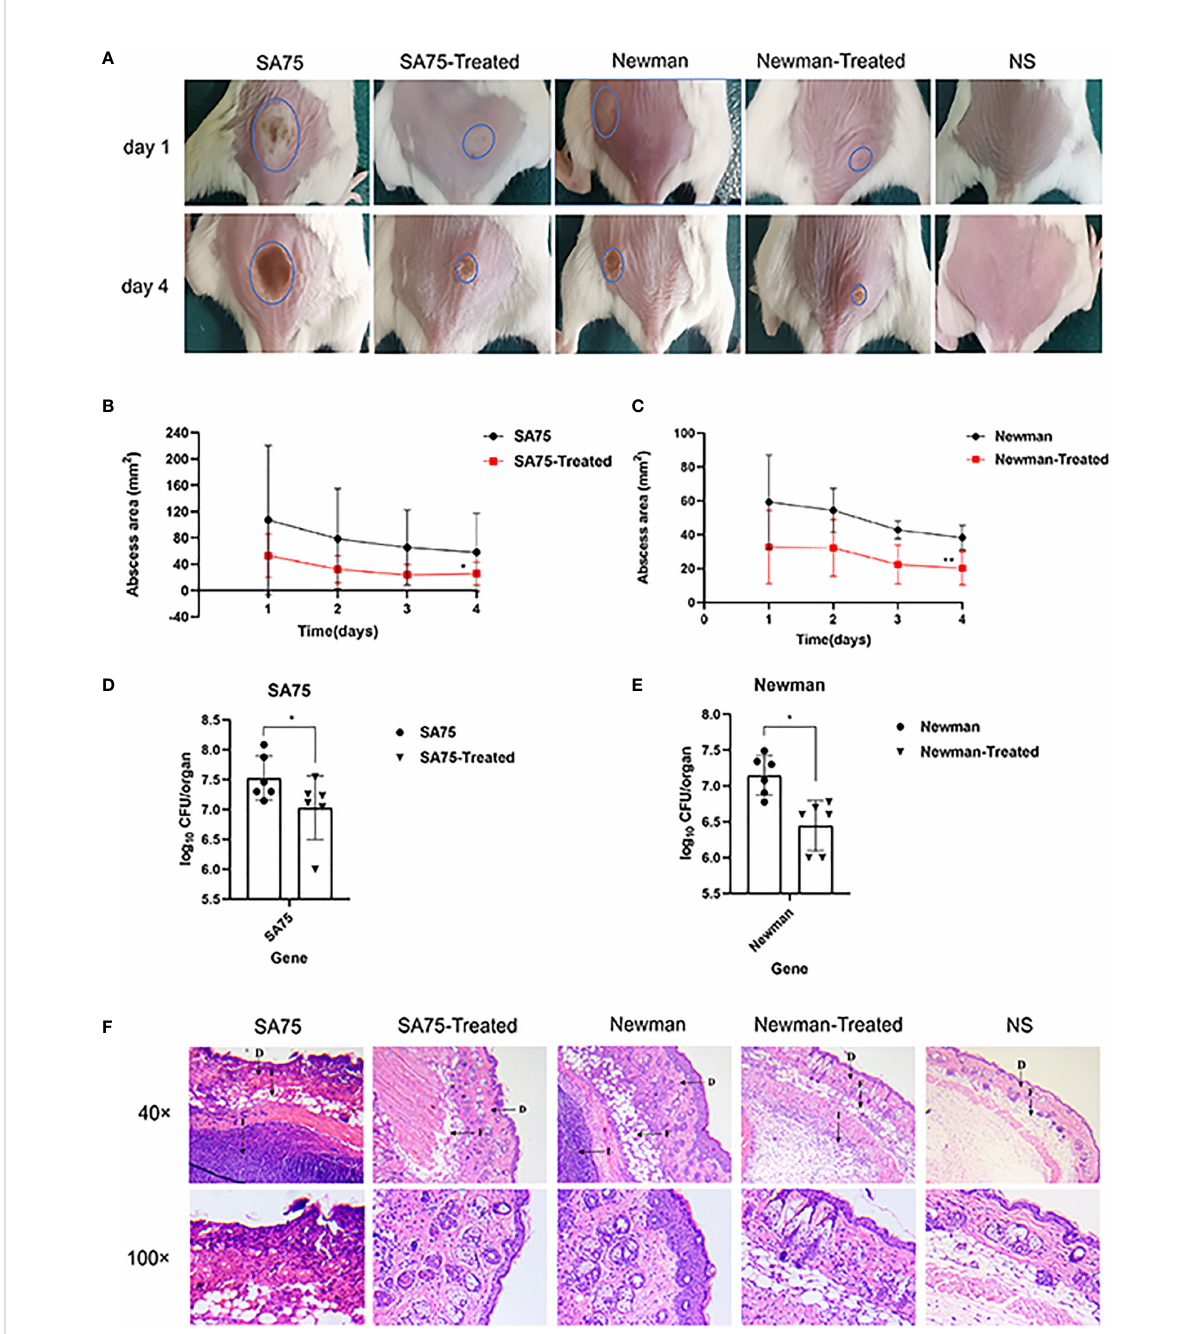
FIGURE 8 In vivo topical application of SYG-180-2-2 against S. aureus . (A) The image of representative abscesses before and after SYG-180-2-2 treated at day 1 and 4 after infection. (B, C) Daily changes of skin abscess area in mice before and after treatment. (D, E) Comparison of bacterial colonies in mice skin of S. aureus wild-type group and S. aureus treated group. (F) On day 4, pathological sections of representative mice between untreated group and treated group, containing two multiples (40× and 100×). D, Dermis; F, Fat layer; I, In fl ammatory cells. * P < 0.05 and ** P <